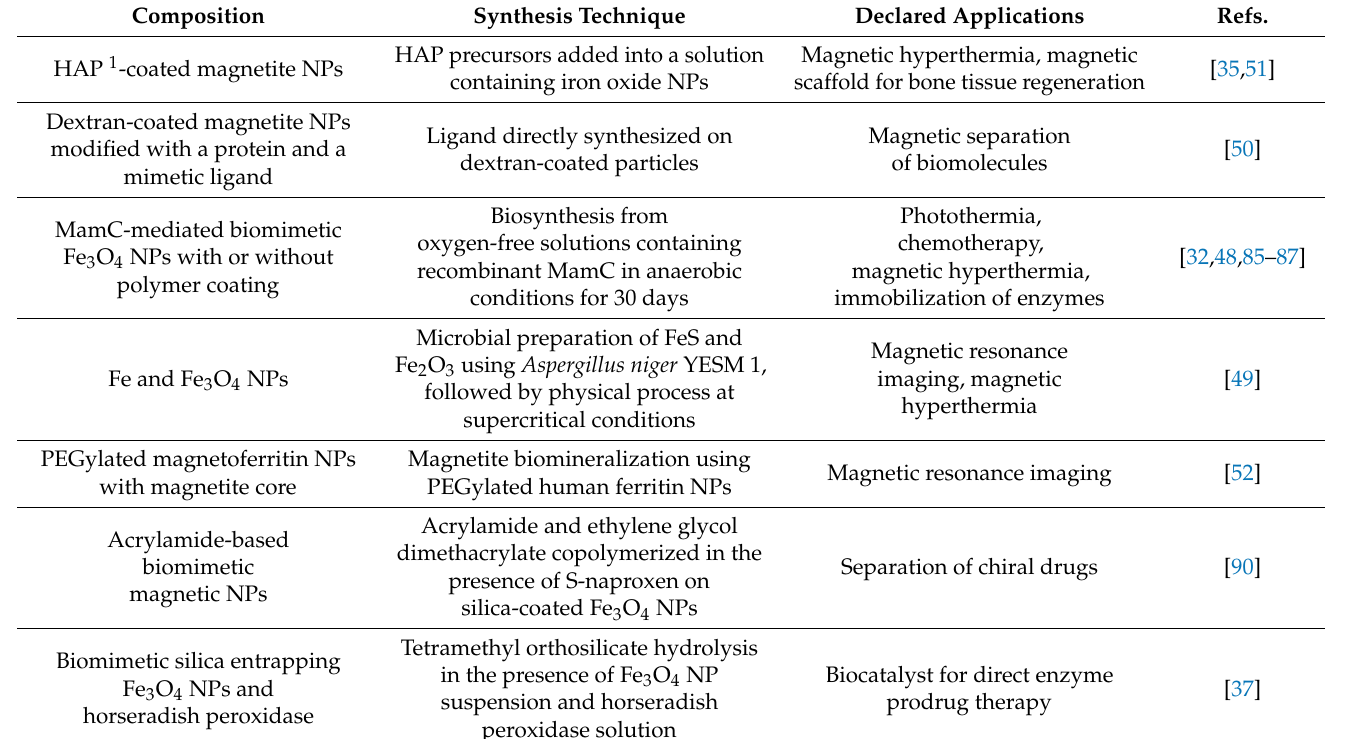
Table 1. Magnetic biomimetic nanomaterials: structure, synthesis, and applications.